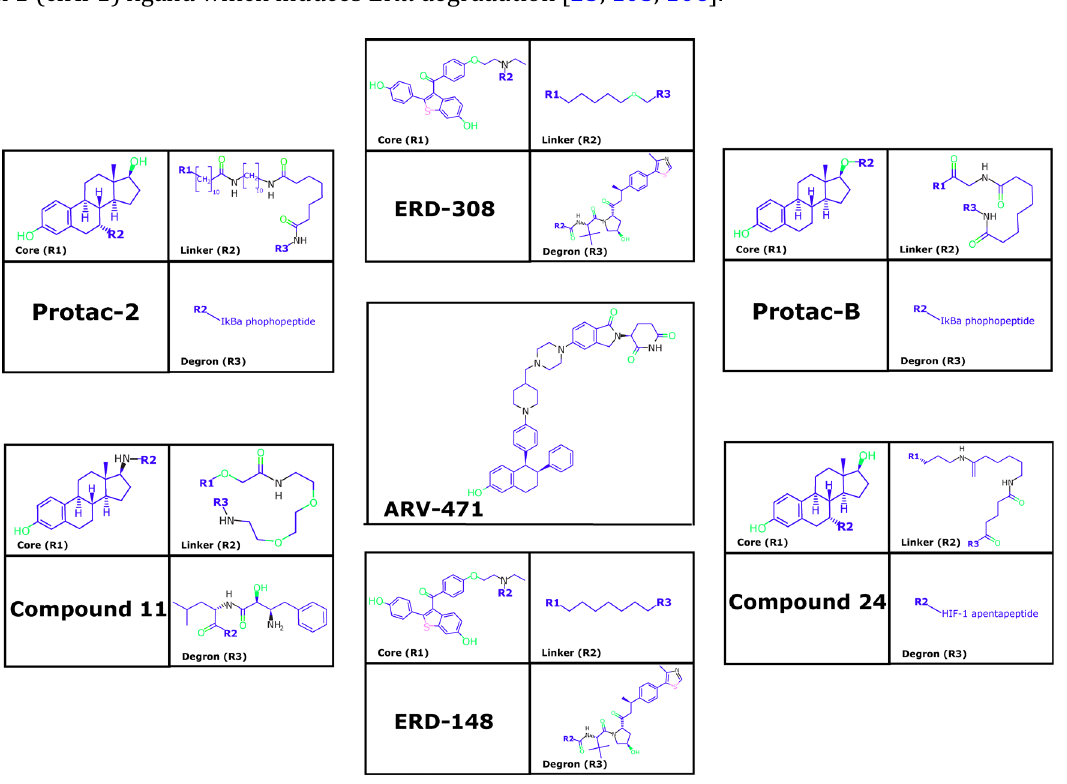
Explor Target Antitumor Ther. 2021;2:496-510 | https://doi.org/10.37349/etat.2021.00060